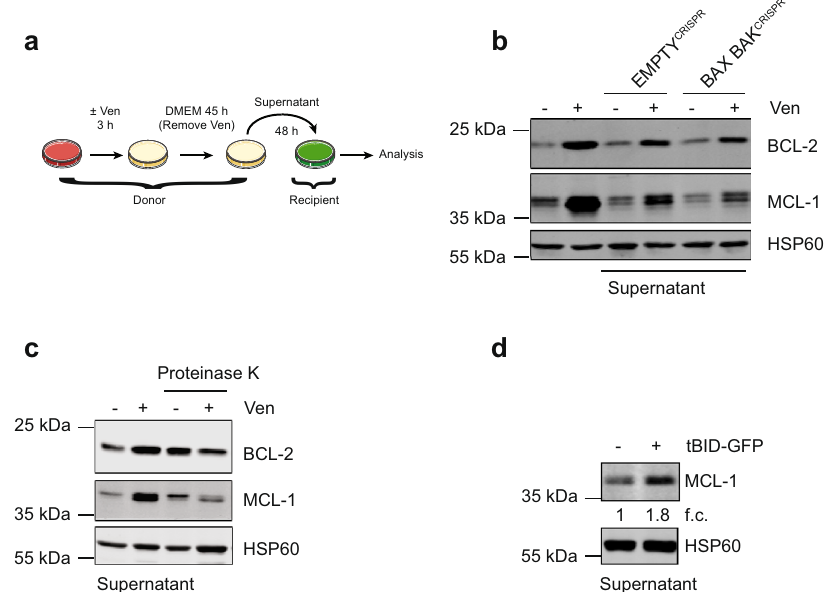
Fig. 2 BH3-mimetics and BH3-only proteins can upregulate anti-apoptotic BCL-2 proteins in a non-cell autonomous manner. a Schematic of supernatant transfer experiments: HeLa tBID2A cells were treated with 500 nM venetoclax for 3 h, followed by exchange to regular growth medium for 45 h. Supernatant was harvested, fi ltered and added onto recipient cells before analysis. b HeLa tBID2A cells were treated directly with venetoclax or with supernatant from untreated or venetoclax treated control or BAX BAK CRISPR cells as described in a . After 48 h cells were harvested and protein expression was analysed by western blot (representative blot of three independent repeats). c Supernatant from control or venetoclax treated cells was digested with Proteinase K before addition onto recipient cells and protein expression was analysed by western blot after 48 h (representative blot of three independent repeats). d Supernatant from HeLa cells transfected with tBID-GFP was collected after 48 h and transferred onto recipient HeLa cells. After 48 h, recipient cells were harvested and protein expression analysed by western blot. Fold change normalised to loading control is stated below (representative blot of